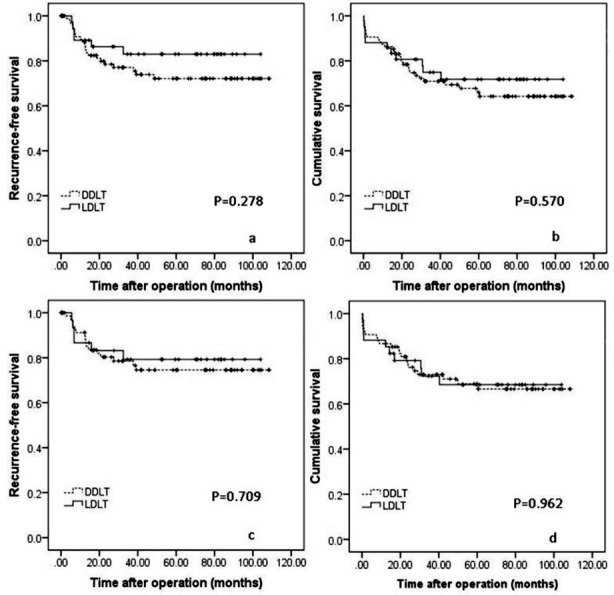
Comparison of the RFS (figure 2a) and OS (figure 2b) rates of LDLT and DDLT for patients with HCC within UCSF criteria. RFS (figure 2c) and OS (figure 2d) curves of LDLT versus DDLT for patients with HCC within up-to-seven criteria